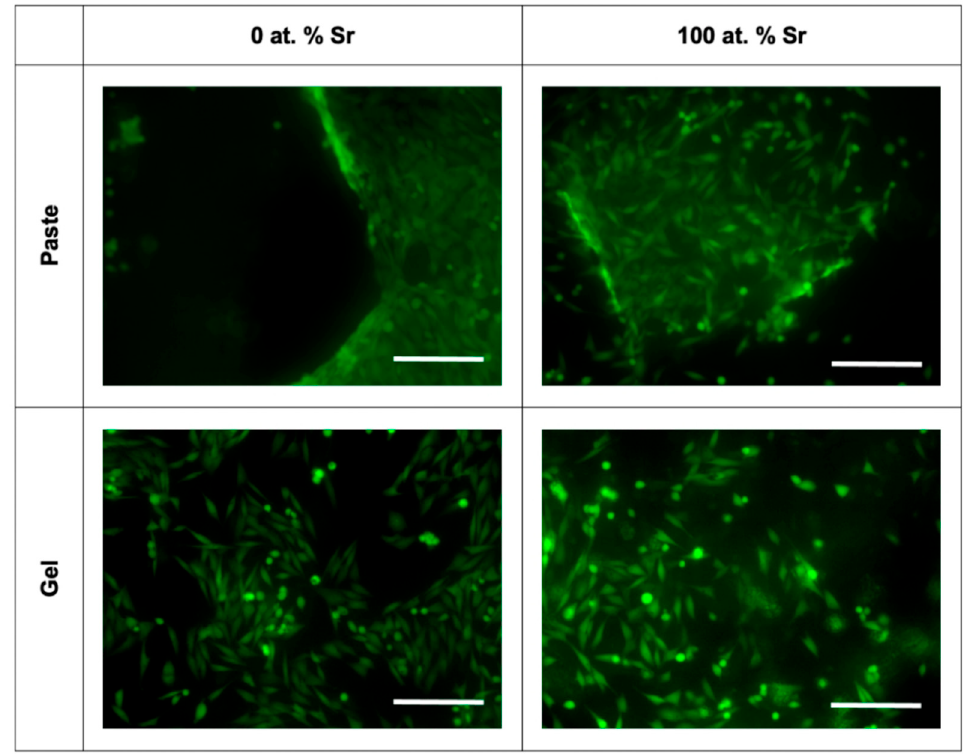
Figure 8. Live fluorescence imaging for MG63 cells cultured directly with SrHA paste and gel (0 and 100 at.% Sr). Scale bar = 200 µm.